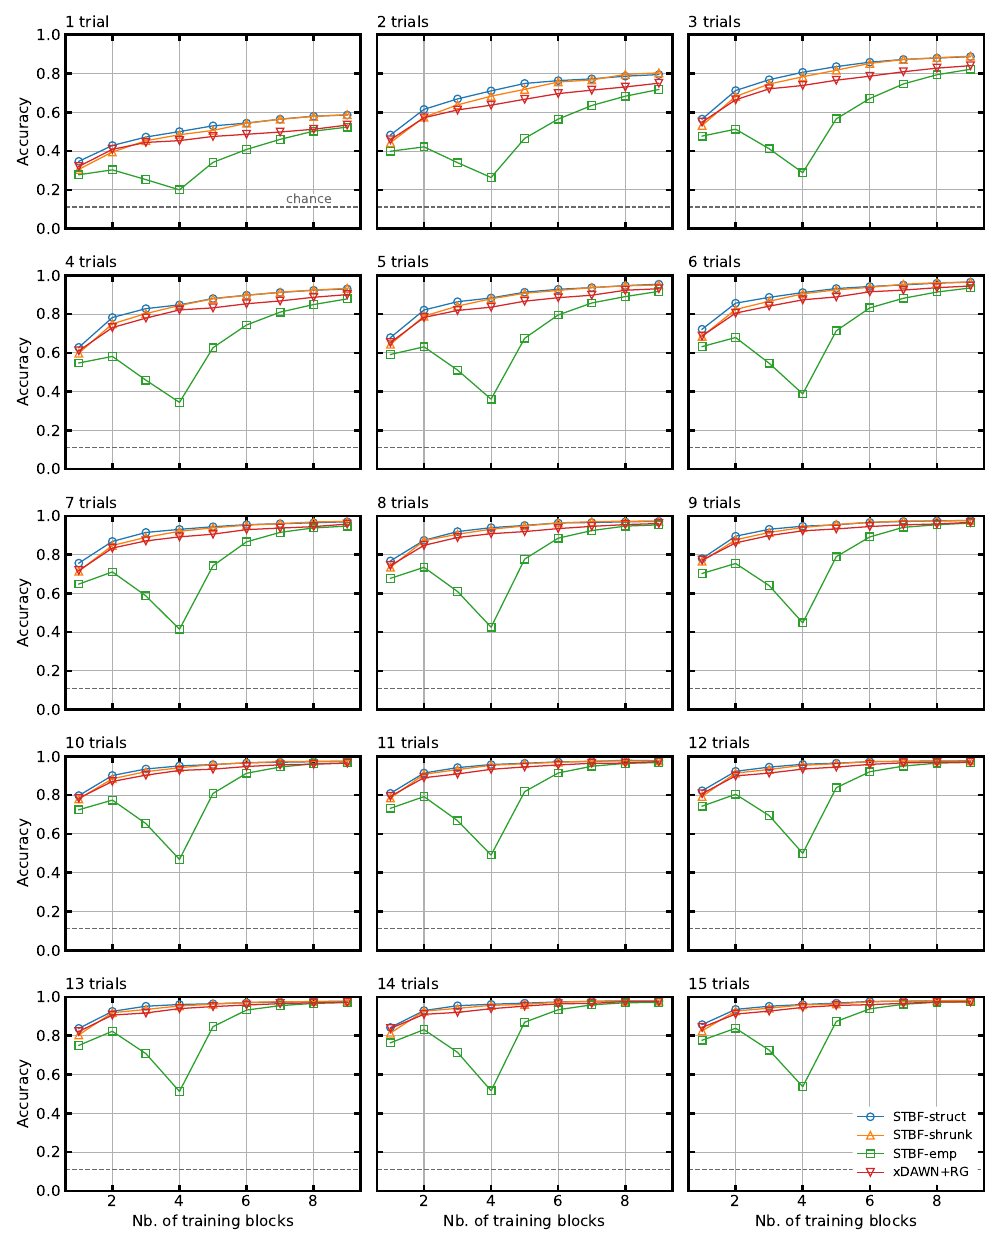
Figure A1. Accuracy of the different classifiers for all 21 subjects relative to the number of blocks available for training. One block consists of 135 epochs and corresponds to 27 s of stimulation. Accuracies are shown for the evaluation settings, averaging over different numbers of trials, ranging from 1 to